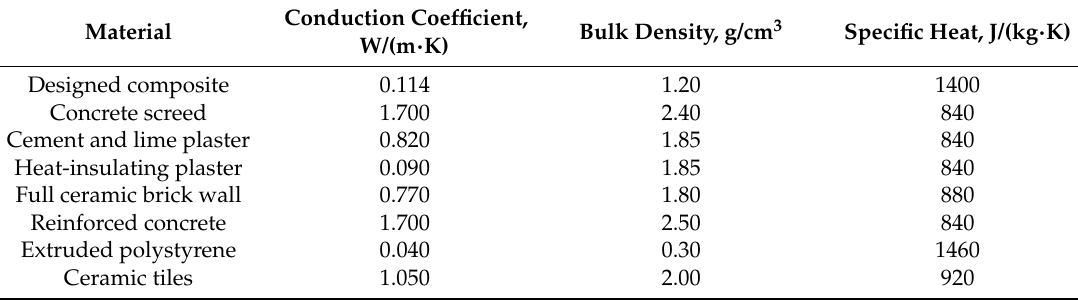
Table 3. Technical specifications of the materials used in the construction of the numerical model.